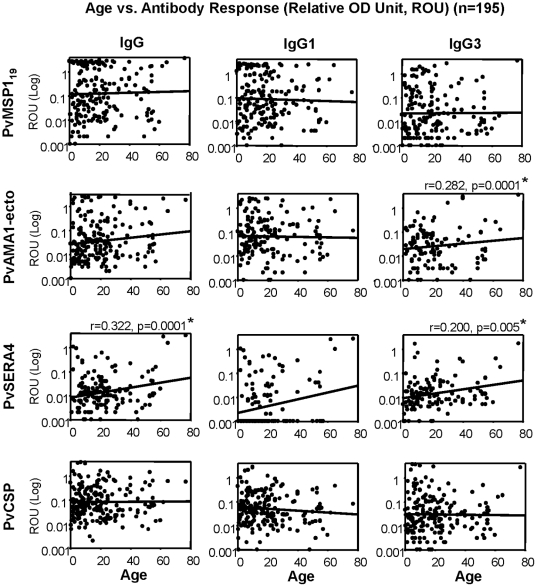
Correlation between age and total IgG, IgG1 and IgG3 antibody responses (ROU) to P. vivax MSP119, PvAMA1-ecto, PvSERA4 and chimeric PvCSP antigens in all individuals (n = 195).Correlations were evaluated using Spearman's correlation test. Significantly correlated values were marked on the each figure (*).